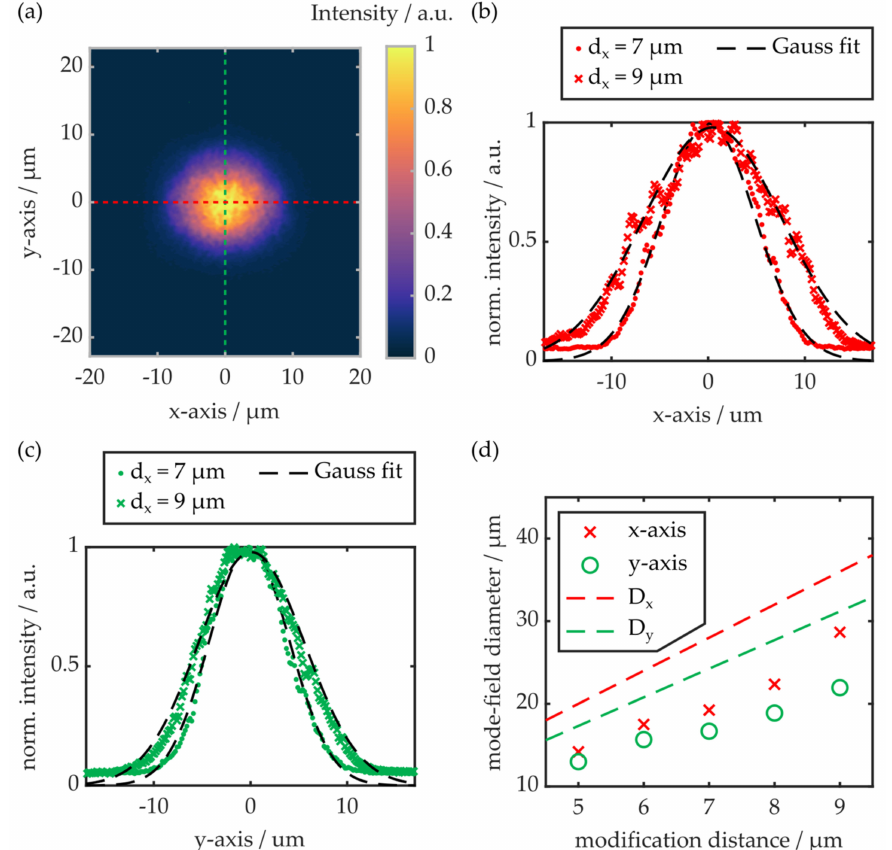
Figure 4. ( a ) Exemplary near-field image of an S-PCWG with a modification distance of 7 µ m. ( b ) Intensity distribution along the x-axis cross-section for waveguides with modification distances of 7 and 9 µ m. ( c ) Intensity distribution along the y-axis cross-section. ( d ) Mode-field diameter as a function of the modification distance. The respective core diameters in x- and y-direction are also